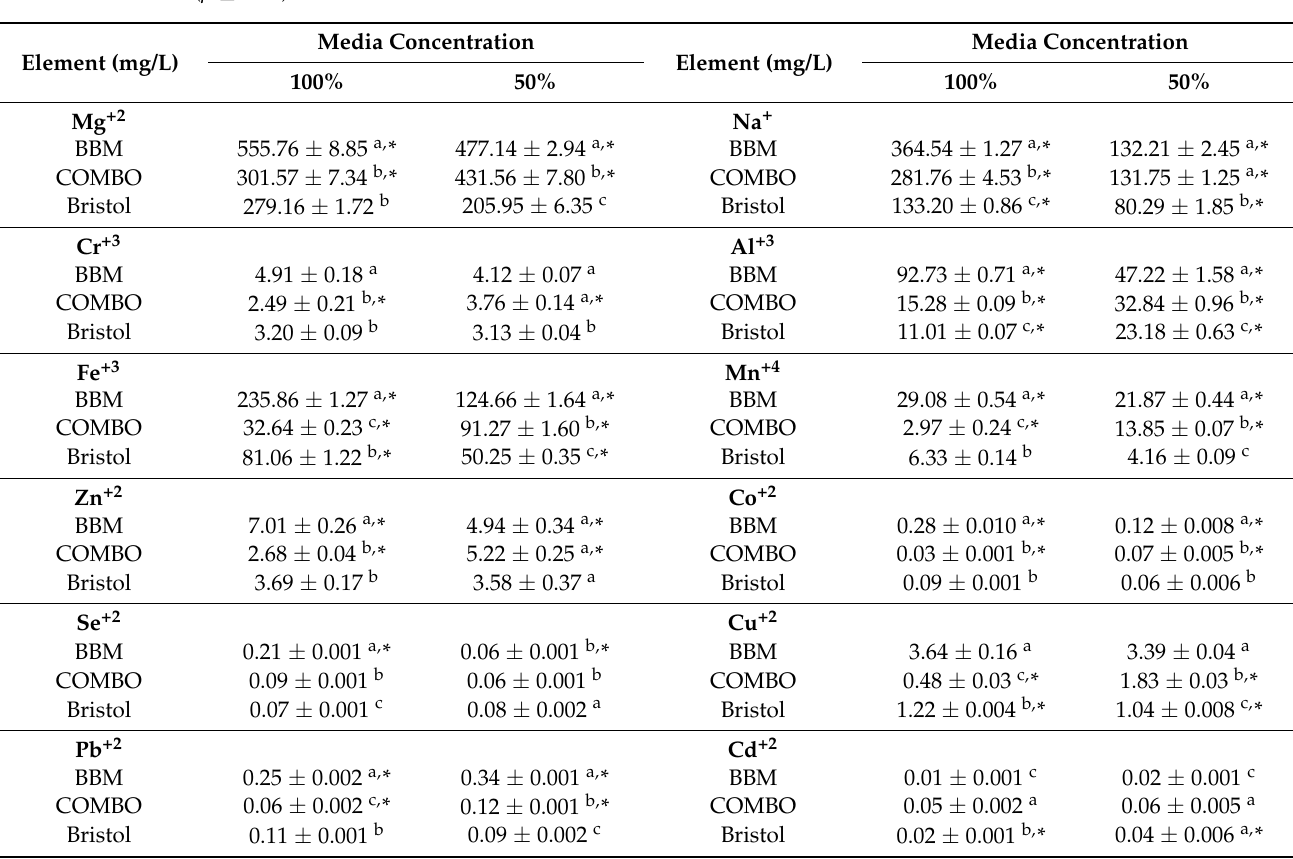
Table 4. Mineral composition of Ankistrodesmus falcatus cultured in different media. Numbers are means ± standard errors. a–c Value under the same parameter represents the mean samples with a significant difference between culture media ( p ≤ 0.05). * Value under the same parameter represents the mean samples with a significant difference between concentrations ( p ≤